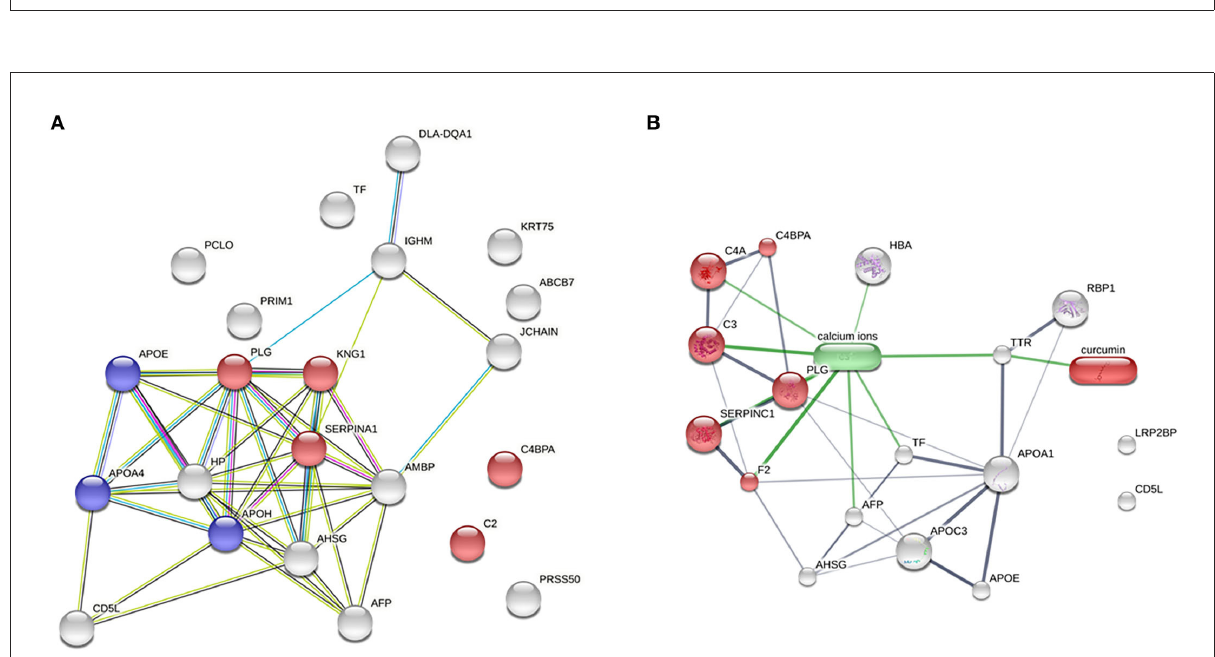
FIGURE3 Gene ontology of the molecular function, cellular component and biological process categories for proteins’ differential expression in the DM day 0 group, as compared to other groups.